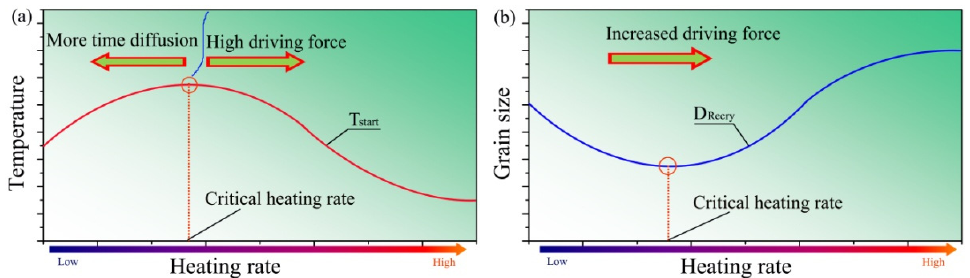
Figure 10. Schematic illustration for the suggested influence of heating rate on ( a ) the initiation of recrystallization; ( b ) recrystallized grain size.